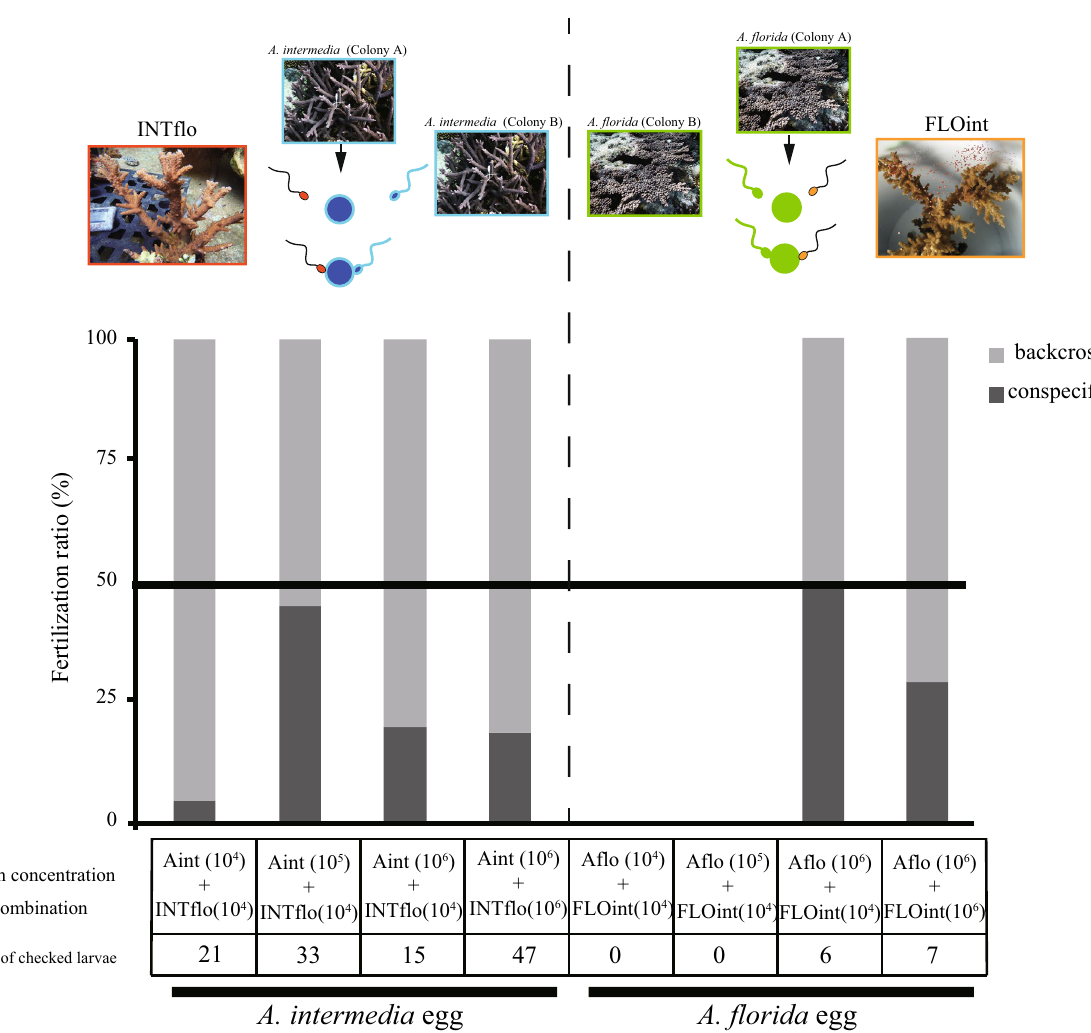
Figure 2. Backcrossing of hybrid sperm with parental species. Sperm choice experiments using eggs of the parental species are shown. Light grey bars indicate the fertilization ratio of parental species sperm, and white bars indicate the sperm of the hybrid species. Microsatellites were checked using electrophoresis or Microsatellite Analysis v1.0 (Applied Biosystems) software (https:// www. therm ofish er. com/ order/ catal og/ produ ct/ 43818